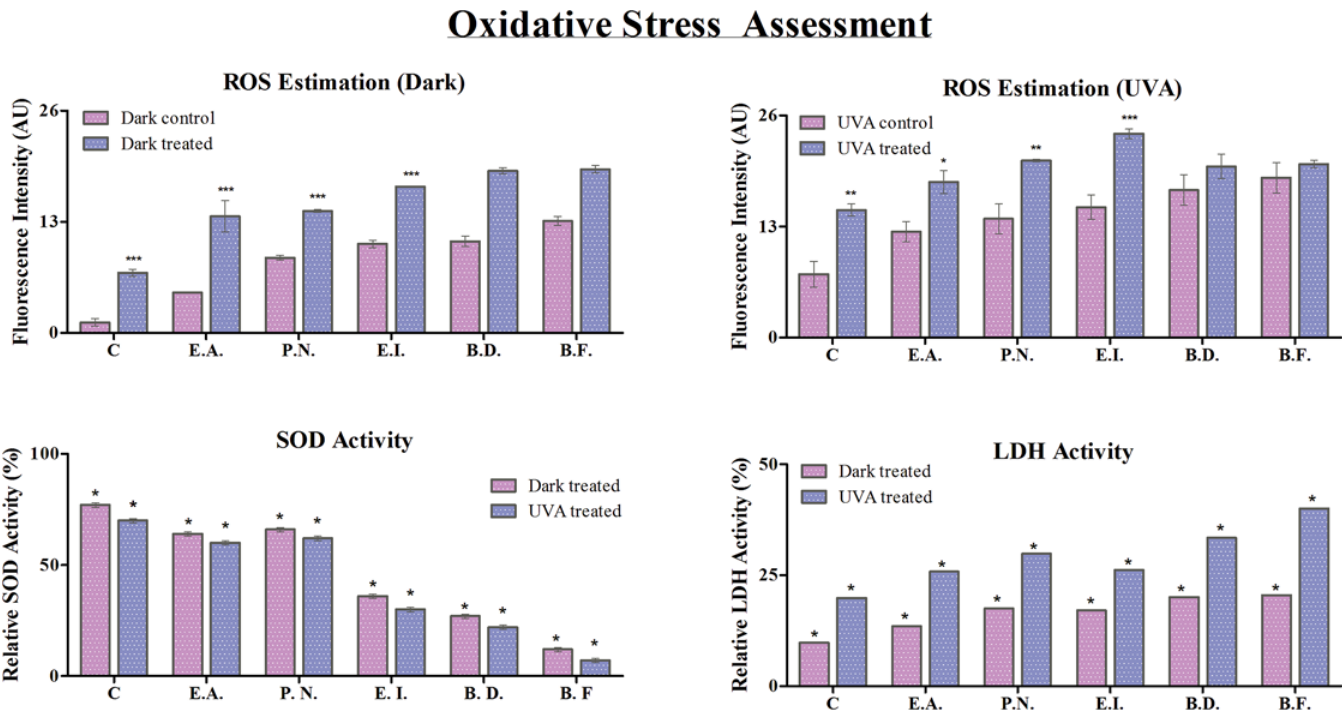
Fig 3. Oxidative stress analysis: Reactive oxygen species (ROS), relative SOD activity (%) and relative LDH activity at 1 μ g/ml of TiO 2 -NPs treated cells under dark and UVA condition with respect to control is shown. Significant difference between control and treated cells is represented by ‘ * ’ .